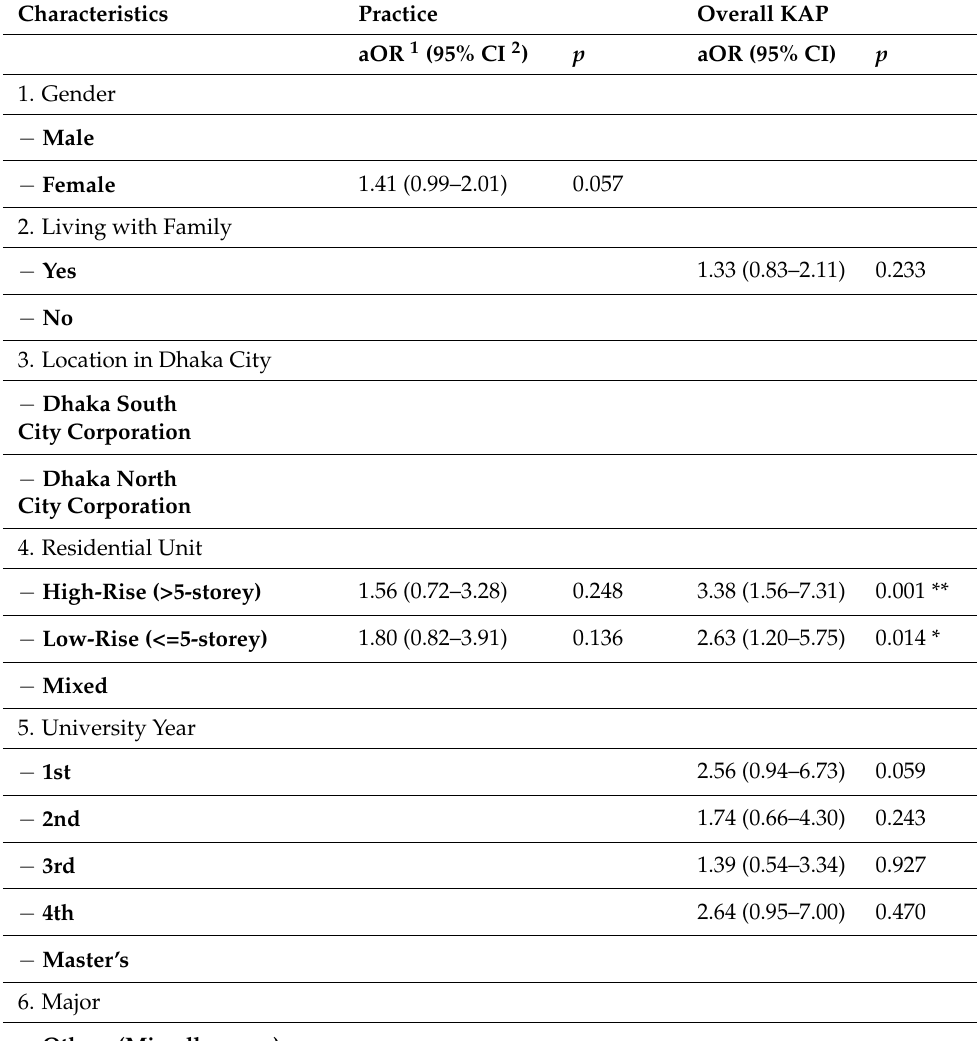
Table 7. Multiple analysis predictors of preventive practices and overall KAP level towards dengue fever among university students of Dhaka City, Bangladesh.